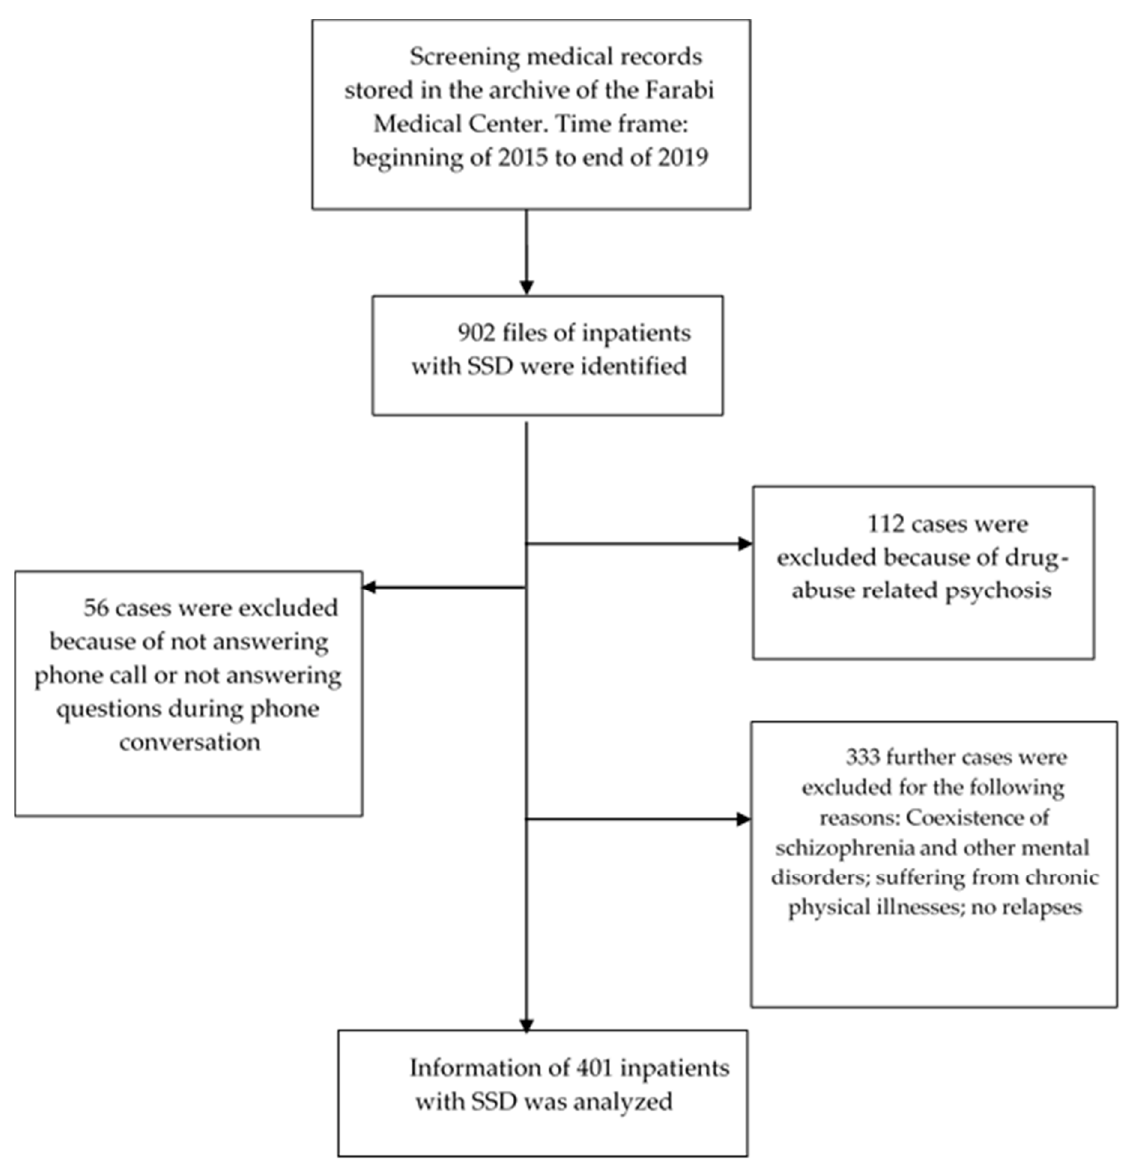
Figure 1. CONSORT diagram, data pool, and inclusion and exclusion criteria. (Schizophrenia Spectrum Disorder (SSD)).